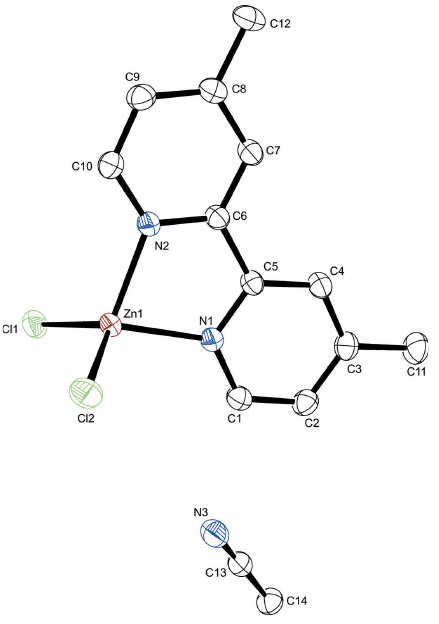
Figure 1 The structures of the molecular entities of the title compound with displacement ellipsoids drawn at the 50% probability level; H atoms are omitted for